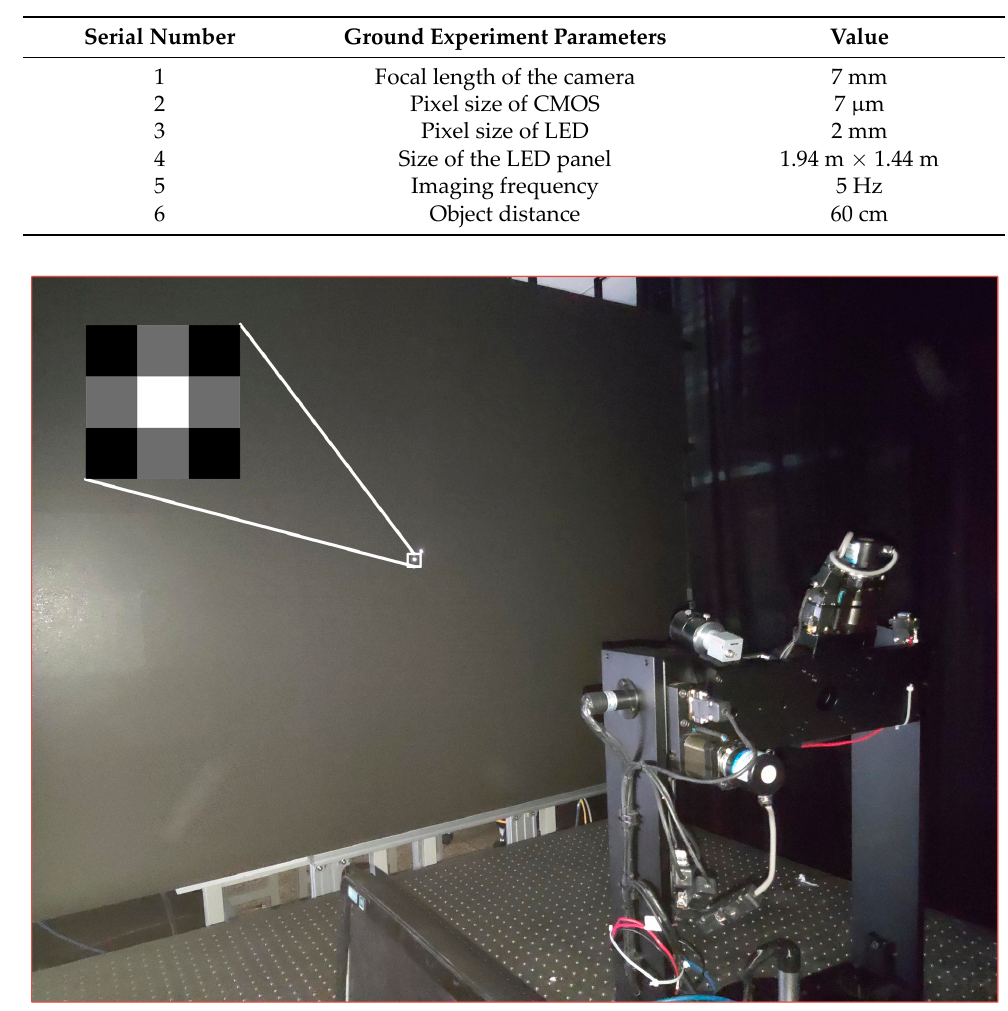
Figure 13. Ground physics simulation experiment system.